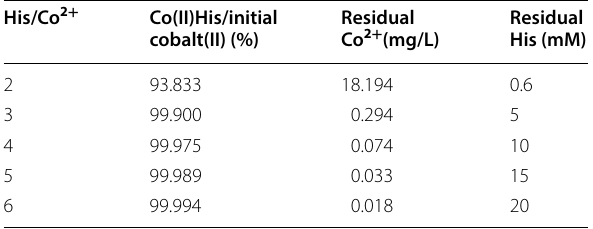
Table 1 Theoretical calculation of the substance content in reaction 5 when it reached equilibrium at